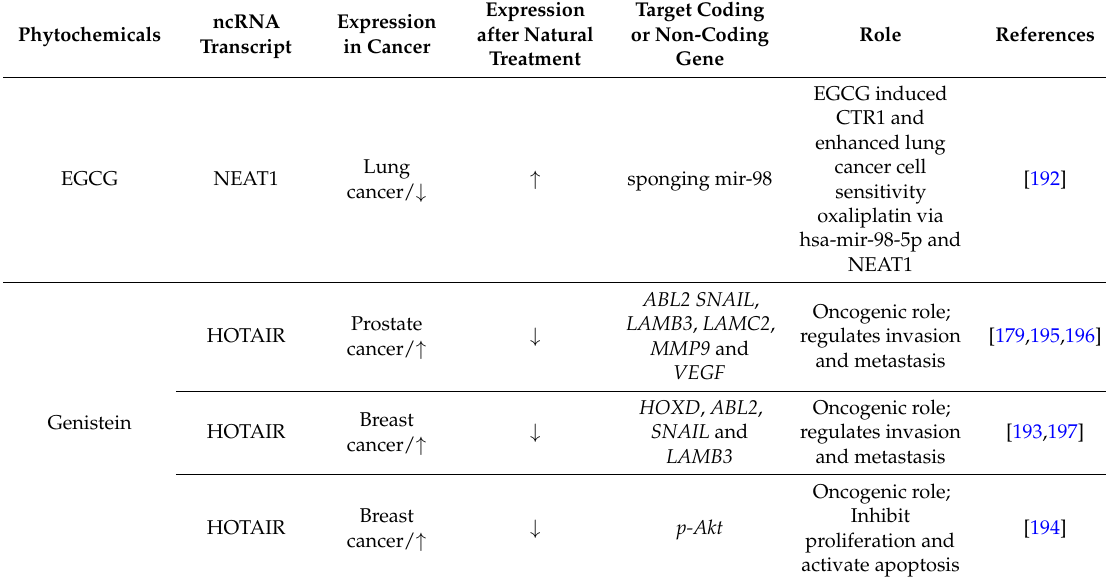
Table 3. The role of epigallocatechin gallate (EGCG) and genistein on modulation of lncRNA